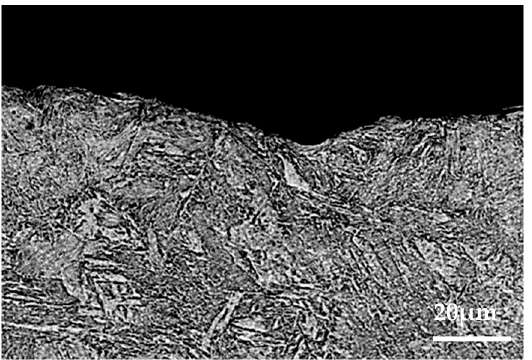
Figure 21. Profile photo of the disc material after intermittent brake wear at an ambient temperature of 0 °C.